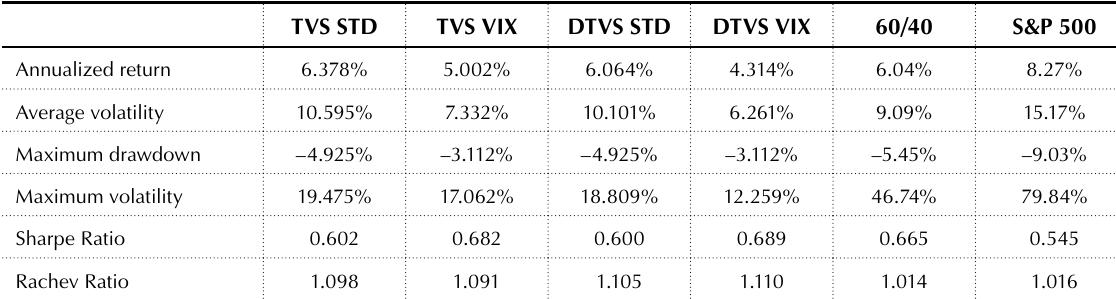
Table 3. Portfolio statistics for rebalancing buffer case removing risk-free